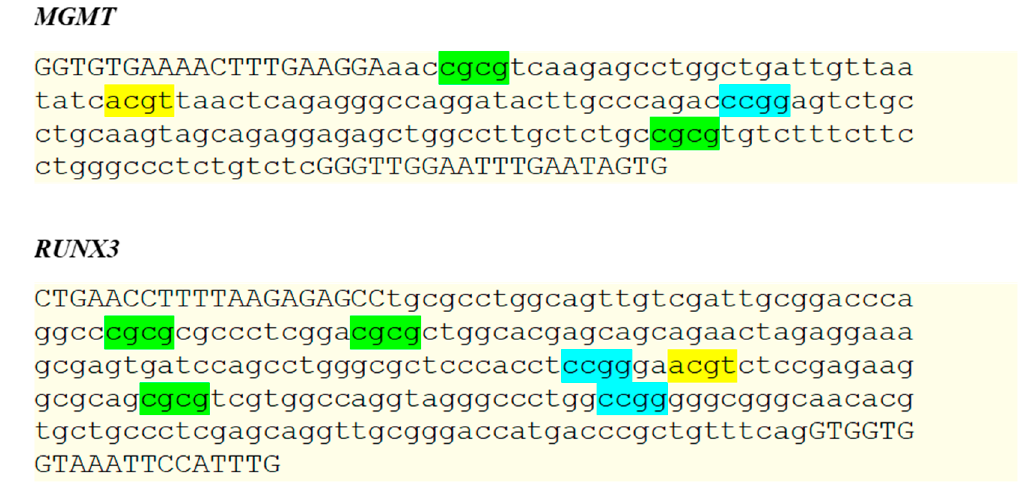
Figure 1. Expected products for MGMT and RUNX3 primer sets. We designed RUNX3 primers to obtain a product 150 to 350 bp long with at least 2–4 MSRE sites. A mix of restriction enzymes was used for each amplicon. Capital letters indicate primer sequences. Green, blue, and yellow highlight restriction sites specific to AccII, HpaII, and HpyCH4IV, respectively.